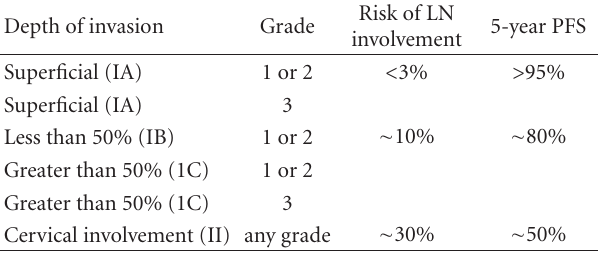
Table 2: Risk of lymph node involvement and 5-year progression free survival based on depth of invasion and